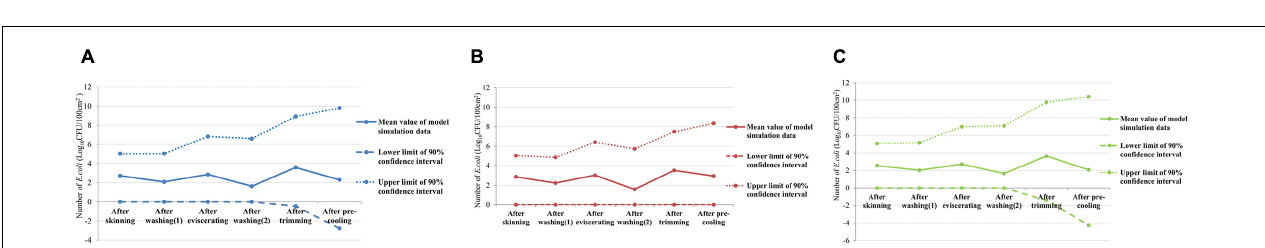
FIGURE 2 | Probability distribution of Escherichia coli contamination of swine carcasses after pre-cooling in slaughterhouses of different sizes. (A) Probability distribution of E. coli contamination of swine carcasses after pre-cooling in all swine slaughterhouses. (B) Probability distribution of E. coli contamination of swine carcasses after pre-cooling in small swine slaughterhouses. (C) Probability distribution of E. coli contamination of swine carcasses after pre-cooling in big swine slaughterhouses. N5- Log number of E. coli on swine carcasses after pre-cooling.